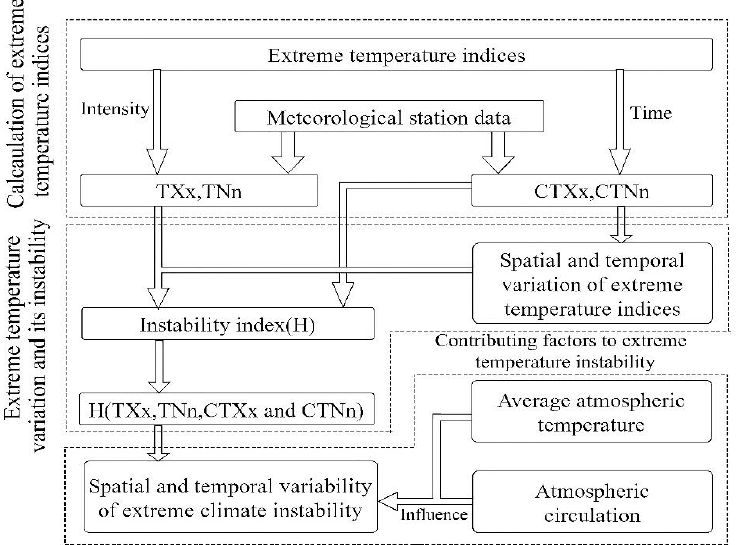
Figure 3. Technical process.